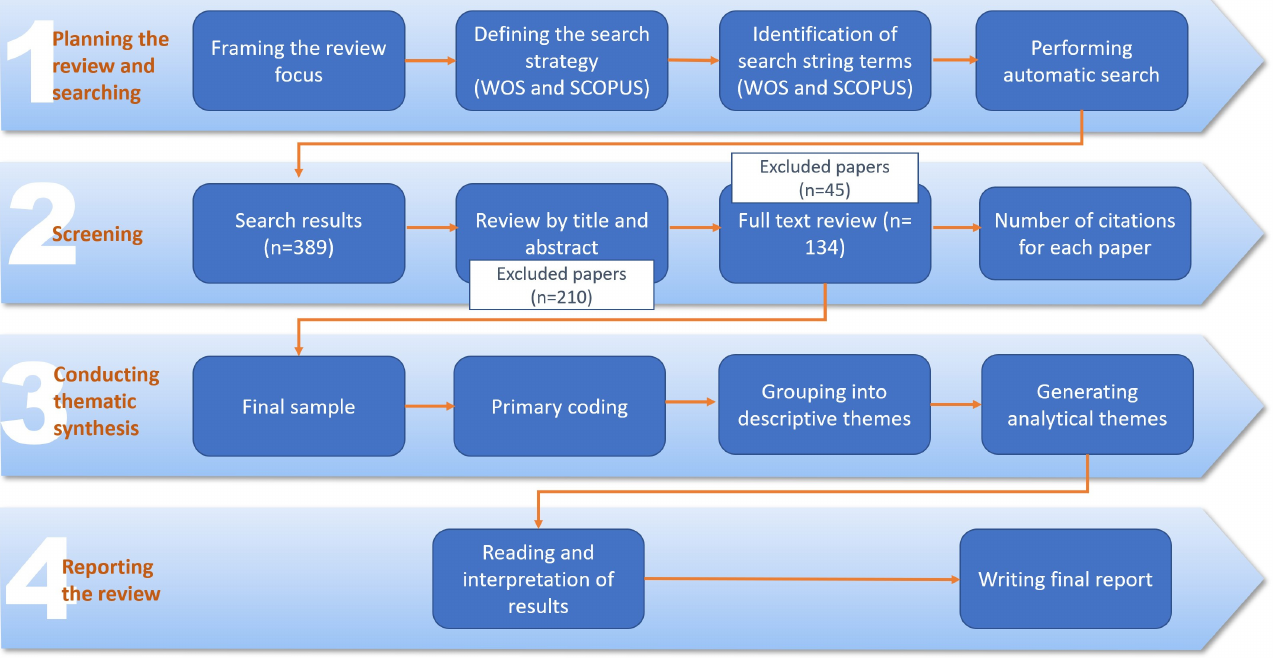
Figure 1. Research